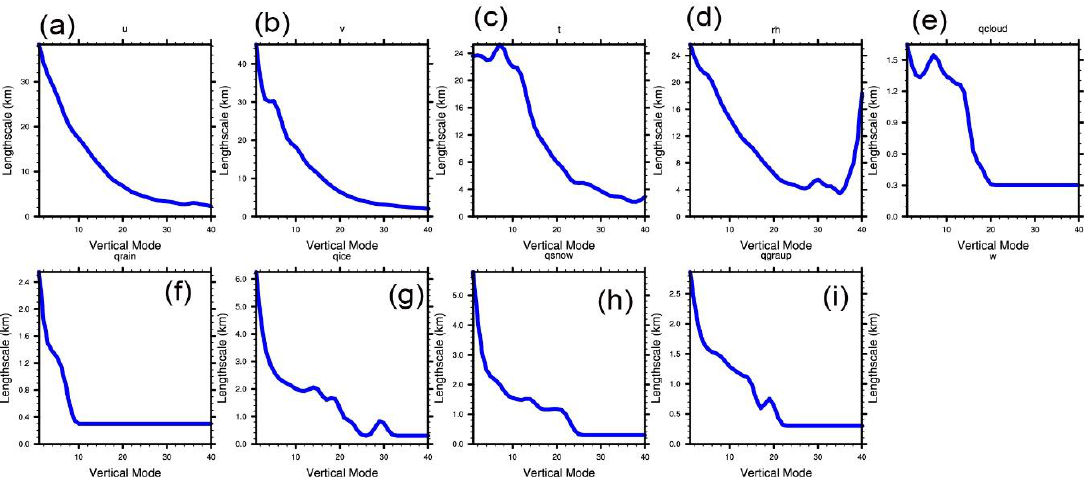
Figure 5. The horizontal correlation length scale for ( a ) u, ( b ) v, ( c ) t, ( d ) rh, ( e ) q c , ( f ) q r , ( g ) q i , ( h ) q s , and ( i ) q g.